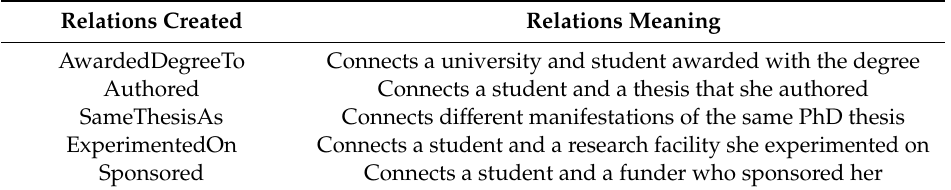
Table 1. Relationships created in the graph database and their